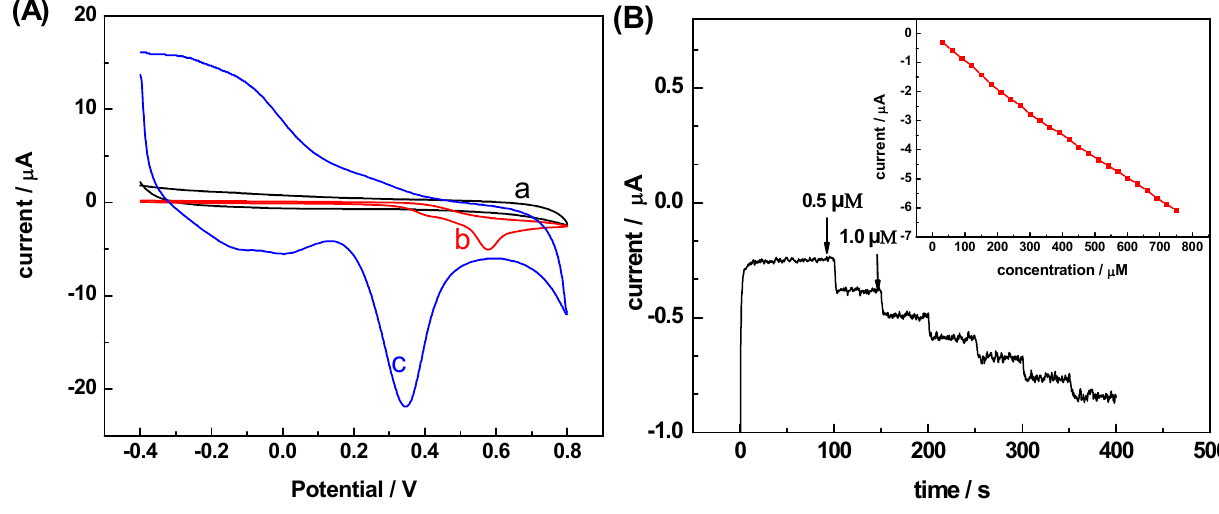
Figure 1. ( A ) Cyclic voltammogrames of the oxidation of NADH on ( a ) bare electrode without NADH; ( b ) bare electrode in 5 mL pH 7.5 Tris-HCl buffer solution containing 0.5 mM NADH; ( c ) MWNT-modified electrode in 5 mL pH 7.5 Tris-HCl buffer solution containing 0.5 mM NADH. Scan rate, 10 mV s − 1 . ( B ) Amperometric responses of